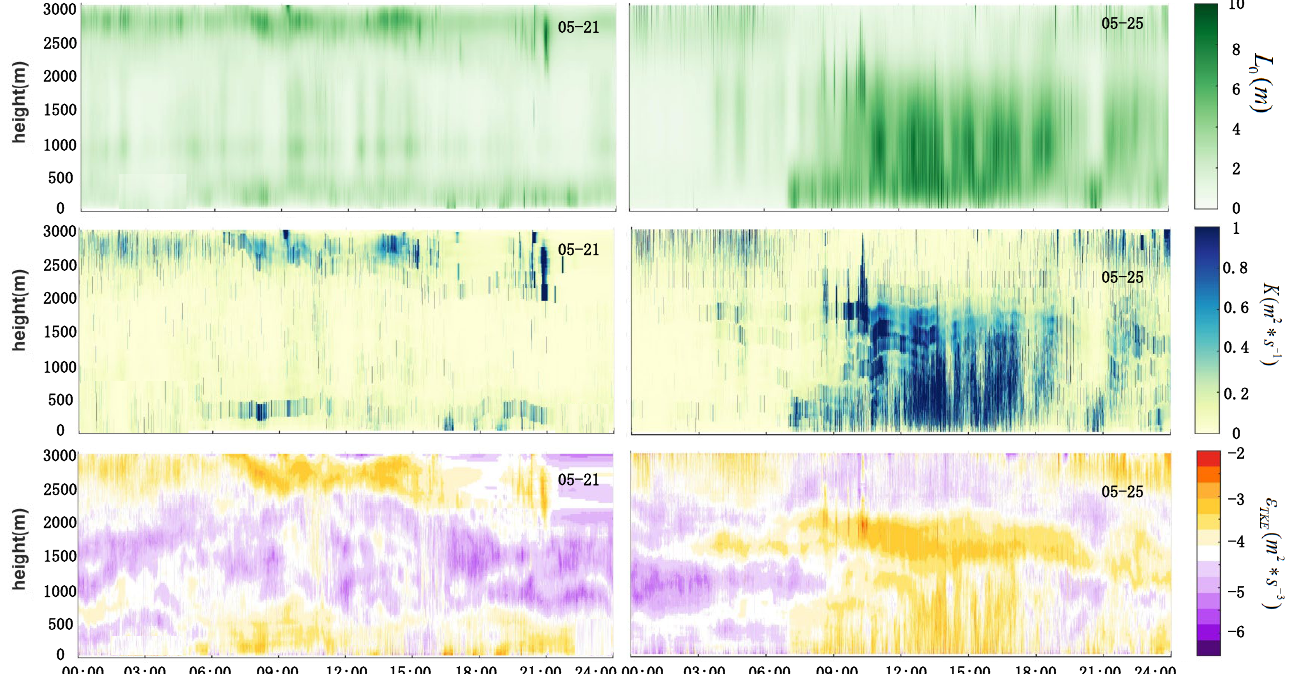
ε in two days. Figure 10. Spatiotemporal distribution of L 0 , K , and ε TKE in two TKE